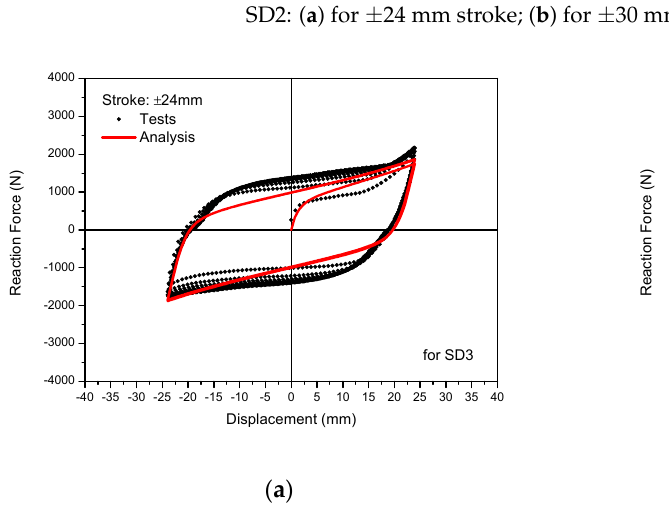
Figure 20. Comparison results of hysteretic behavior between tests and analyses for steel damper, SD3: ( a ) for ±24 mm stroke; ( b ) for ±30 mm stroke.